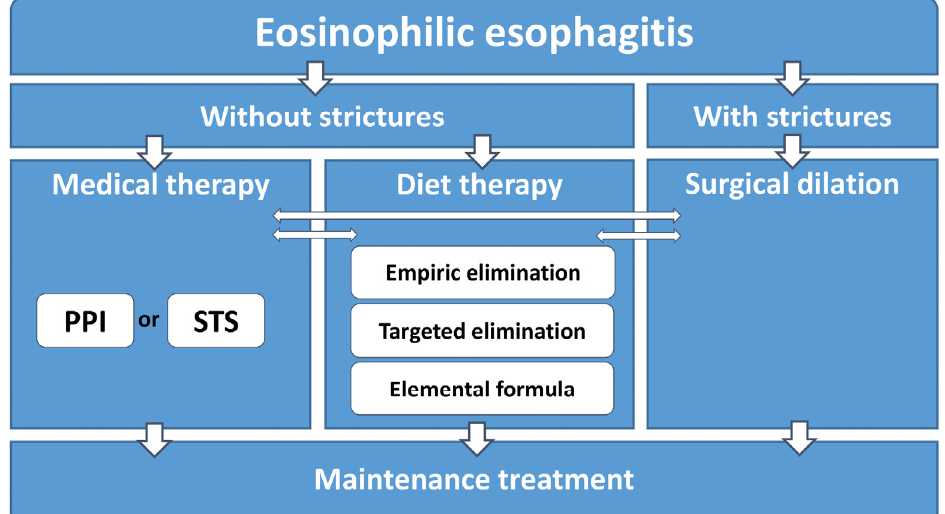
Figure 1. General treatment recommendations in treatment of EoE (PPI—proton pump inhibitors; STS—swallowed topical steroids).